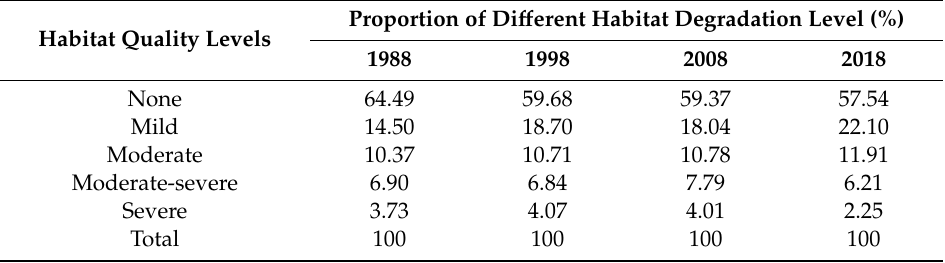
Table 6. The proportion of di ff erent habitat degradation levels in the PLEEZ from